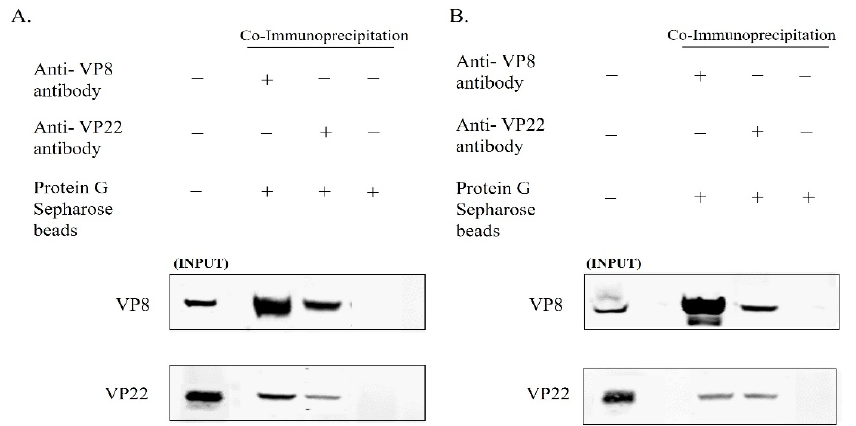
Figure 5. VP8 and VP22 interact during BoHV-1YmVP8 infection. MDBK cells were infected with BoHV-1YmVP8 at an MOI of 0.5 and harvested 18 h post-infection (primary enveloped virus; ( A )) or 30 h post-infection (mature virus; ( B )). Lysates were generated and incubated with mouse VP8-specific monoclonal antibodies or rabbit VP22-specific polyclonal antibodies, followed by Protein Sepharose G beads. VP8 and VP22 were detected by Western blotting with monoclonal anti-VP8 and rabbit anti-VP22 antibodies, followed by IRDye 680RD goat anti-mouse IgG and IRDye 800RD goat anti-rabbit IgG, respectively. Immunoprecipitation of VP8 with VP22—and vice versa—is shown for primary enveloped ( A ) and mature ( B ) virus.